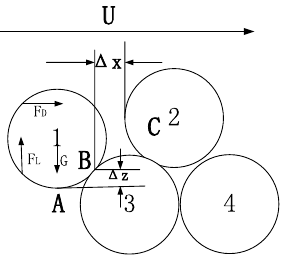
Figure 2. The schematic diagram of the stress on